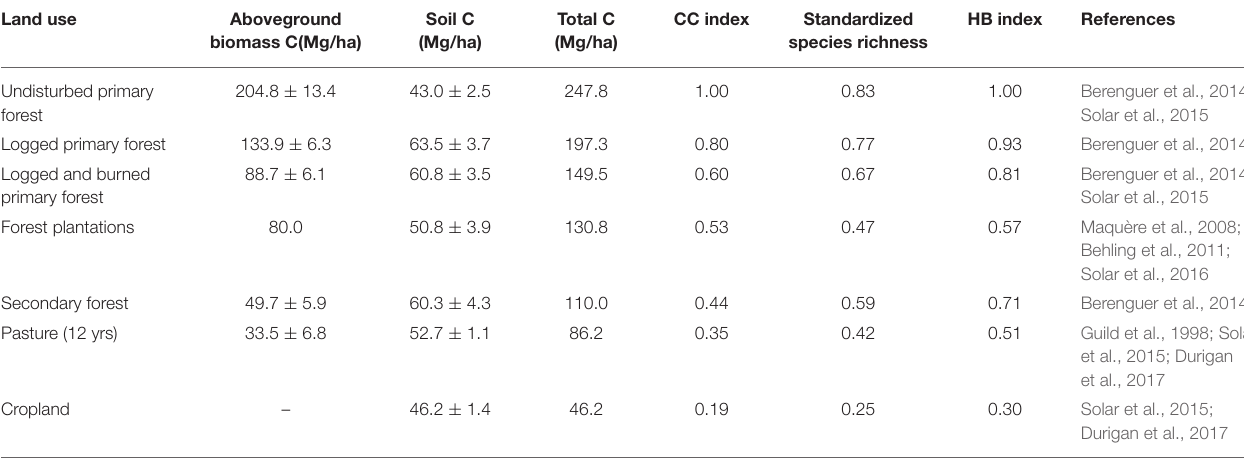
TABLE 1 | Indices for carbon storage and habitat for biodiversity, based on values for indicators from secondary data. Land use